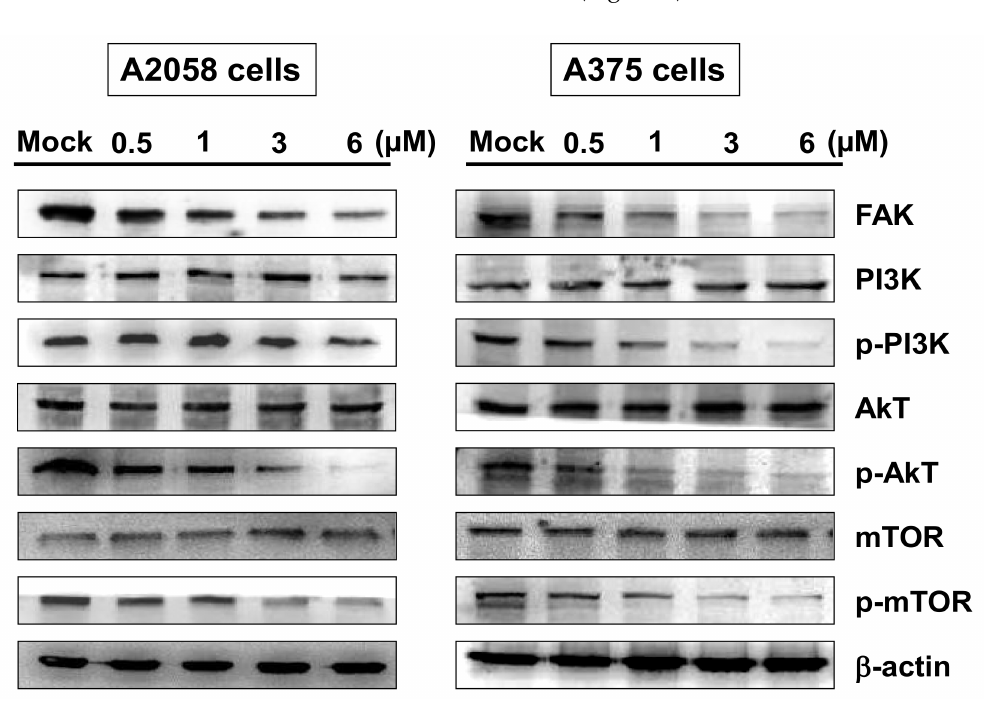
Figure 5. The effects of bornyl cis -4-hydroxycinnamate on the FAK/PI3K/Akt/mTOR signaling pathways in A2058 and A375